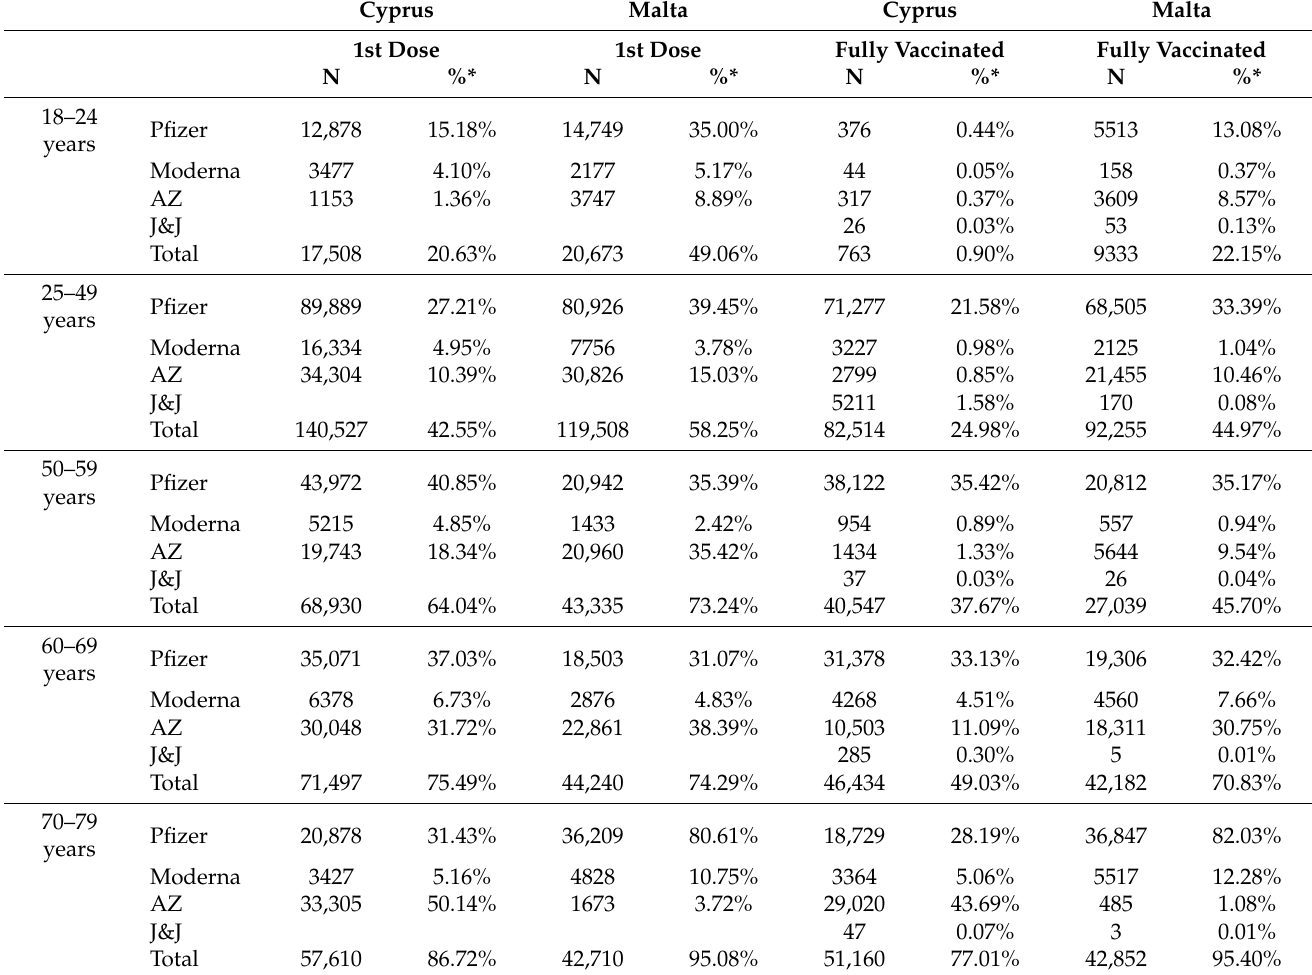
Table 1. Comparative analyses of the first dose and fully vaccinated distribution in Cyprus and Malta by age groups and vaccine brand up until 13 June